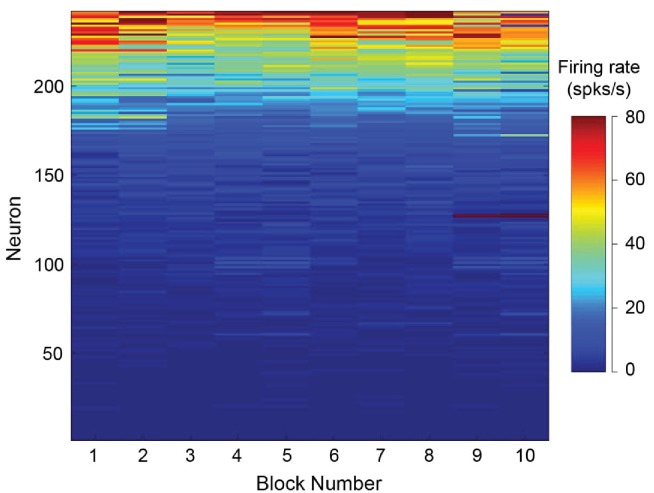
Neural stability over the recording session.After dividing each session into ten blocks, we calculated the mean firing rate during the delay period. We observed that 99% of cells exhibited stable firing rates throughout the recording session (p>0.05, Pearson correlation of each neuron over the ten trial blocks).